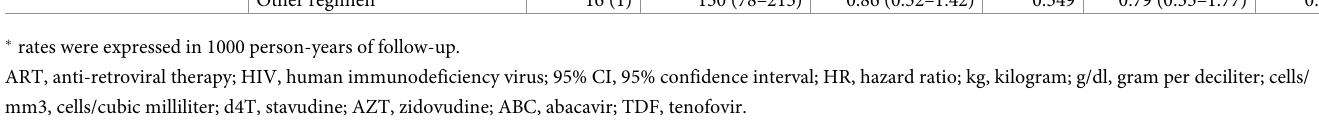
PLOS ONE | https://doi.org/10.1371/journal.pone.0204550 September 25,